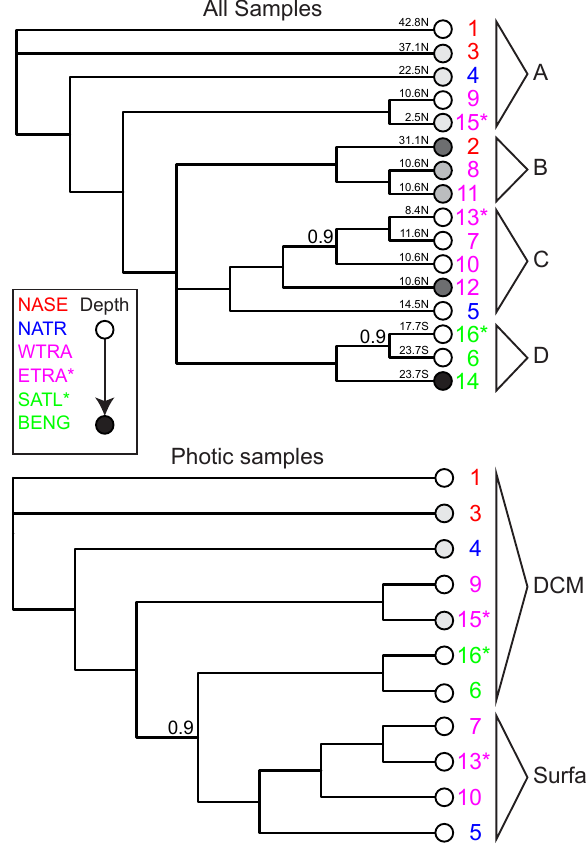
Fig. 6. Tree topology estimated by Bayesian inference operating on the abundance of the OTUs identified at 97% identity. Province is shown by color and depth is indicated by circles of increasing darkness (2–4600m). Only branch posterior probabilities < 1.0 are shown on the tree. The latitude of the sampling location is indicated at the tip of the branches of the “All Samples”